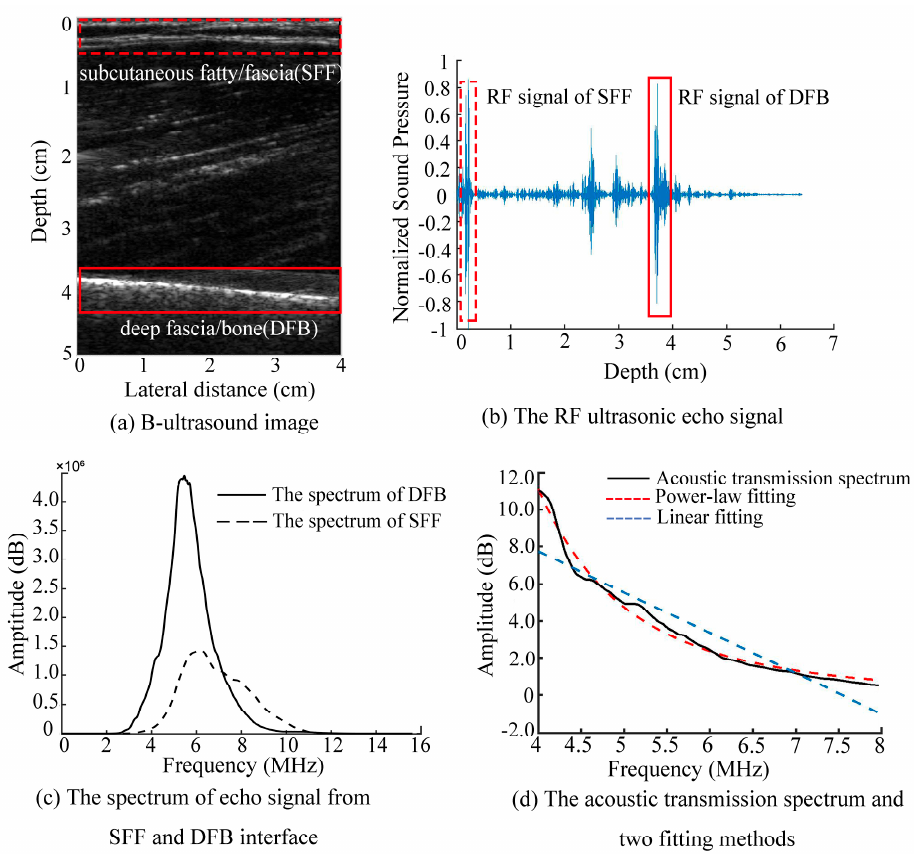
Figure 1. Procedure of data analysis for the acoustic transmission spectrum.